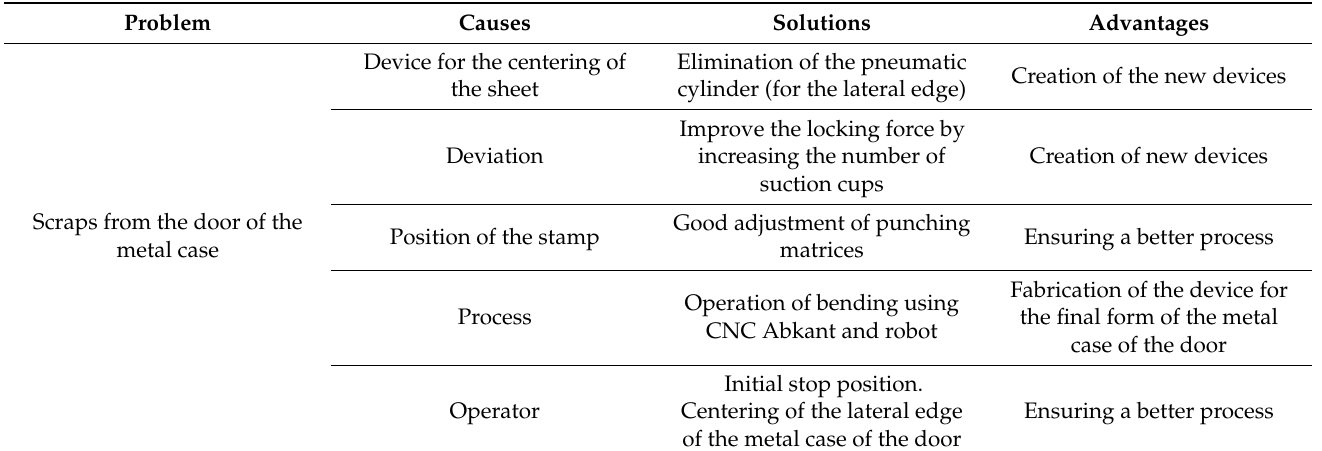
Table 7. Solutions Table 7. Solutions plan.